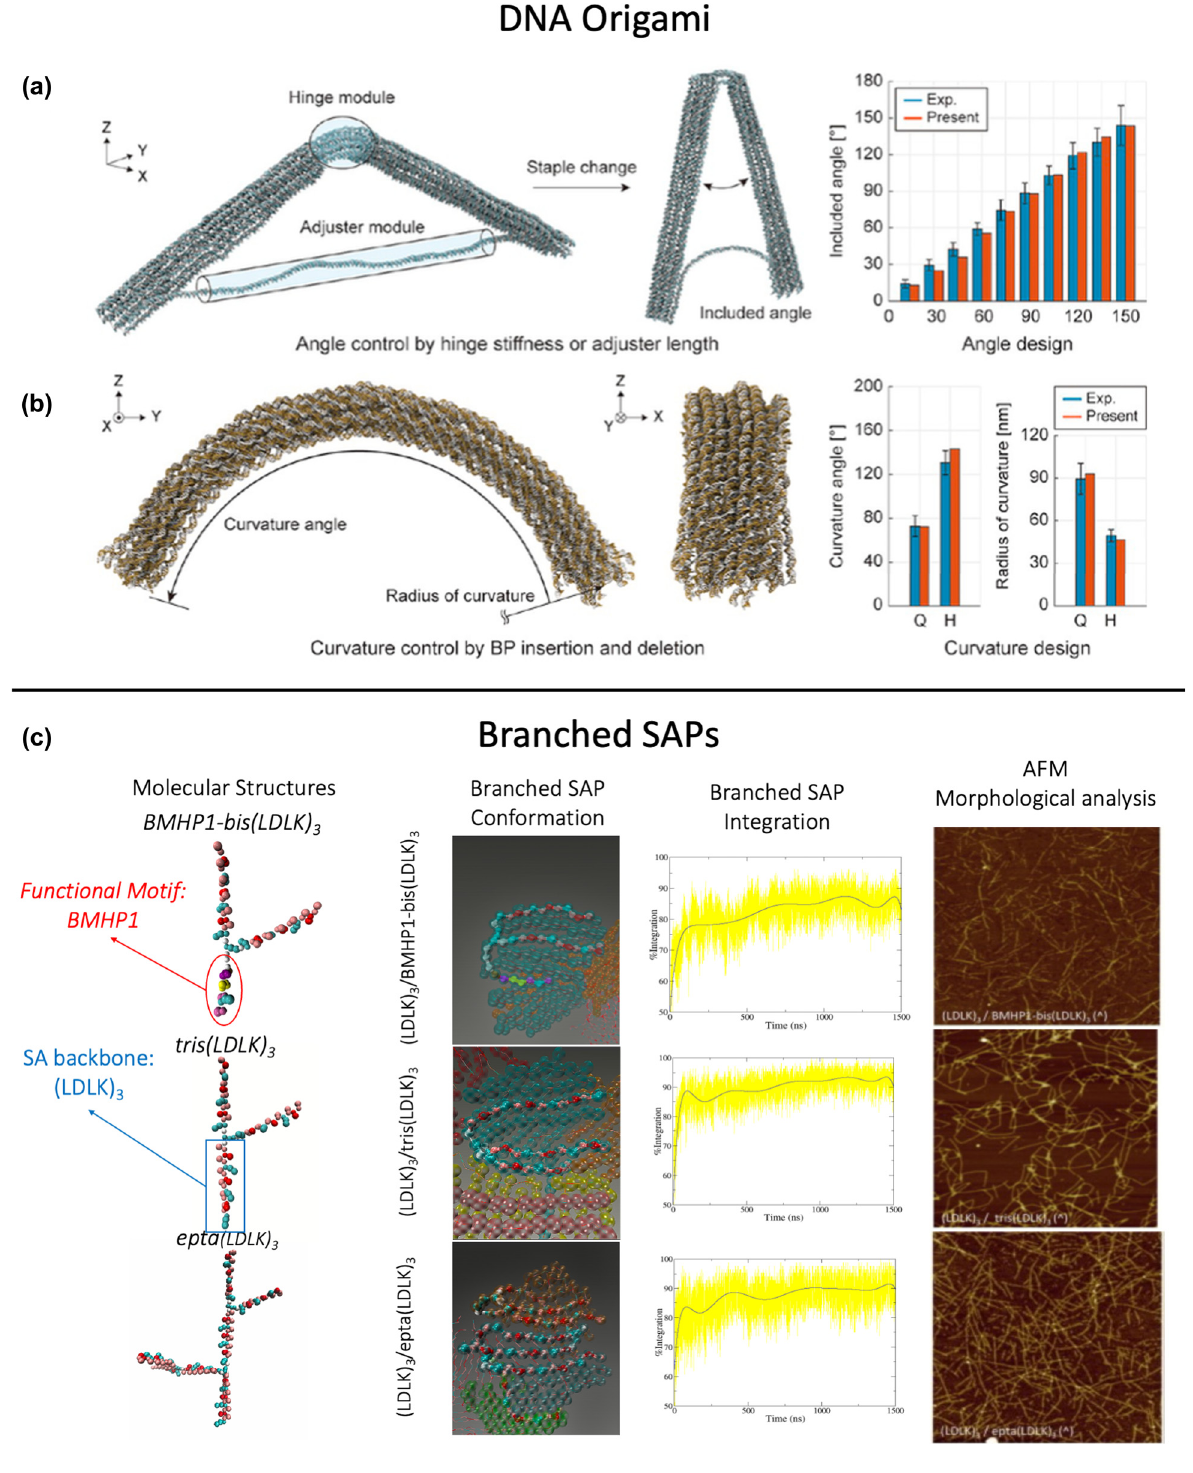
Figure 2: Computational analysis work fl ow for SBP development. ( a ) Analysis of bundle DNA nanostructures through AA - MD simulations. Angle control by hinge sti ff ness or adjuster module length. The designed DNA origami include angles ranging from 15 to 150 and controlled by the sti ff ness of the hinge module and of the adjuster module length. ( b ) Analysis of bundles of DNA nanostructures through AA - MD simulation. Curvature control of DNA origami by BP insertion or deletion. For the quarter ( Q ) and the half ( H ) circle designs, the radius of curvature and the angle of curvature are quanti fi ed by fi t to positions in the predicted structures. Figures ( a ) and ( b ) have been adapted from Lee et al . [ 116 ] , with the permission of ACS publications. ( c ) Work fl ow ( from left to right columns ) for the development of hydrogels from branched SAPs mixed with linear ( LDLK ) 3 . Branched SAPs have been developed starting from ( LDLK ) 3 backbone moieties, connected with one or multiple “ lysine knots. ” Branched SAPs were created by increasing the number of ( LDLK ) 3 - branches and/or by adding the BMHP1 neuro - regenerative functional motif as a single branch. CG - MD simulations unveiled the conformations of branched SAPs within ( LDLK ) 3 self - assembled nanostructures. Then, SAPs were classi fi ed according to their contribution to the stability of fi bril nanostructures by calculating their degree of integration. Lastly ( right column ) , SAP hydrogels were synthesized and characterized via AFM